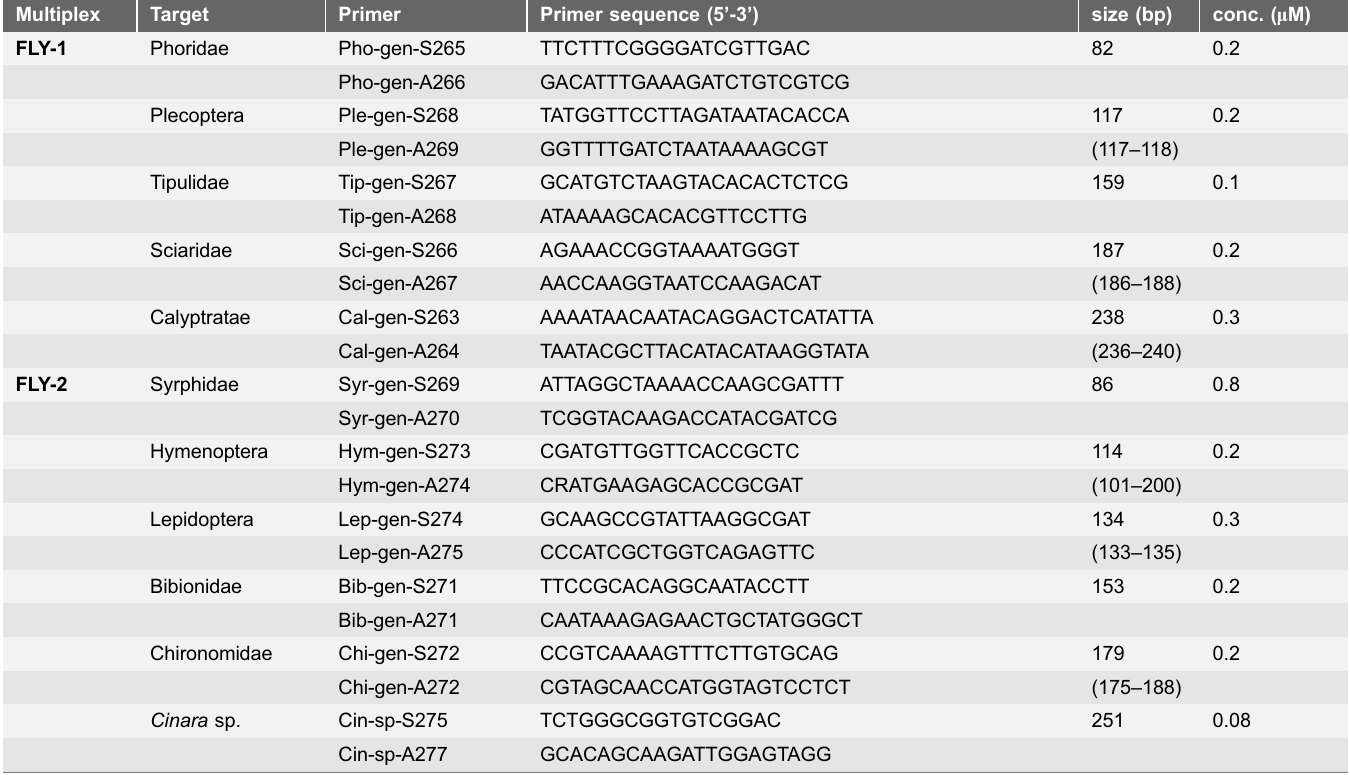
Table 1. Primer pairs included in the multiplex PCR systems FLY-1 and